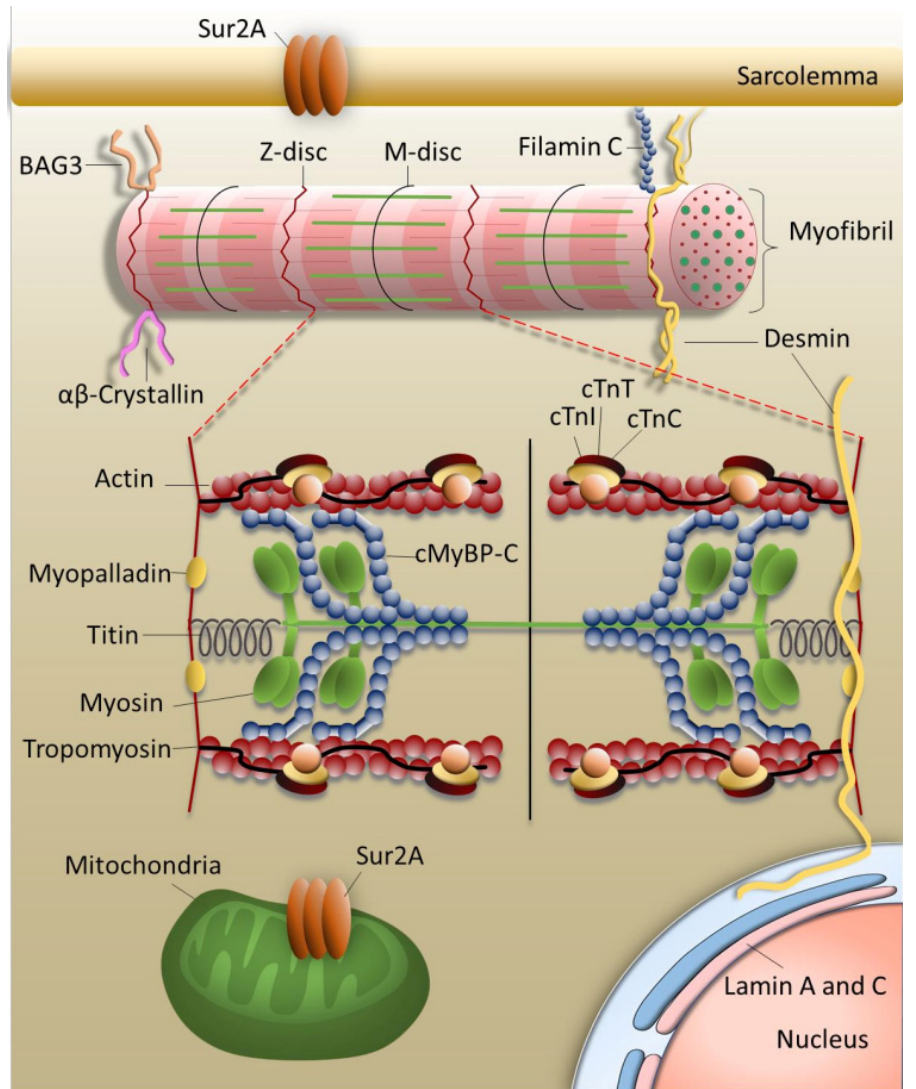
Figure 1. Organization of the contractile machinery. Cardiomyocytes are thickly packed with con- tractile elements, the myofibrils, which are connected to each other and via the cytoskeleton to the extracellular matrix and to the nucleus. Myofibrils are composed of sarcomeres, the smallest con- tractile units of the cardiac muscle cell. Proteins, whose genes are targets for mutations leading to restrictive cardiomyopathy are indicated. cMyBP-C = myosin binding protein C; cTnI, cTnT, cTnC = cardiac troponin subunits I, T and C; Sur2A = sulfonylurea receptor isoform 2A; BAG3 = Bcl2- associated athanogene 3. The figure was created using PowerPoint (Microsoft).